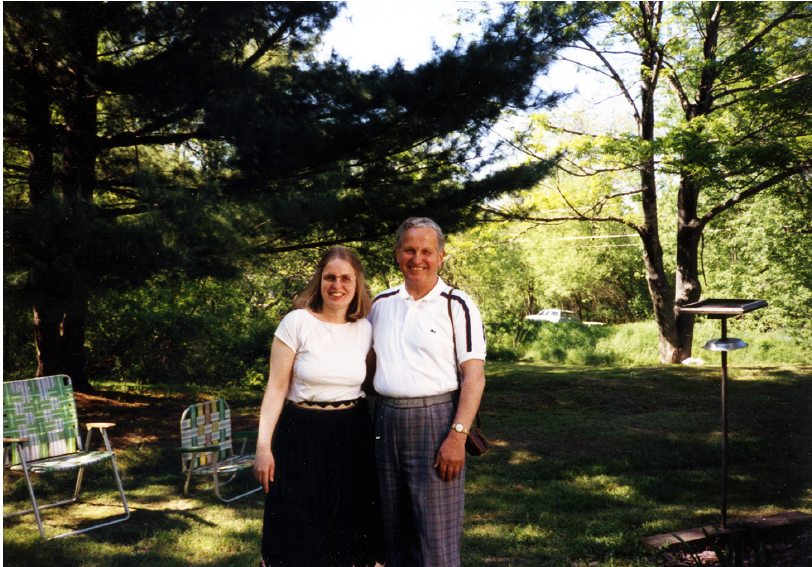
Figure 1: Claudia and her father Rudolf at her PhD graduation party in Ithaca, NY, in the summer of 1989.